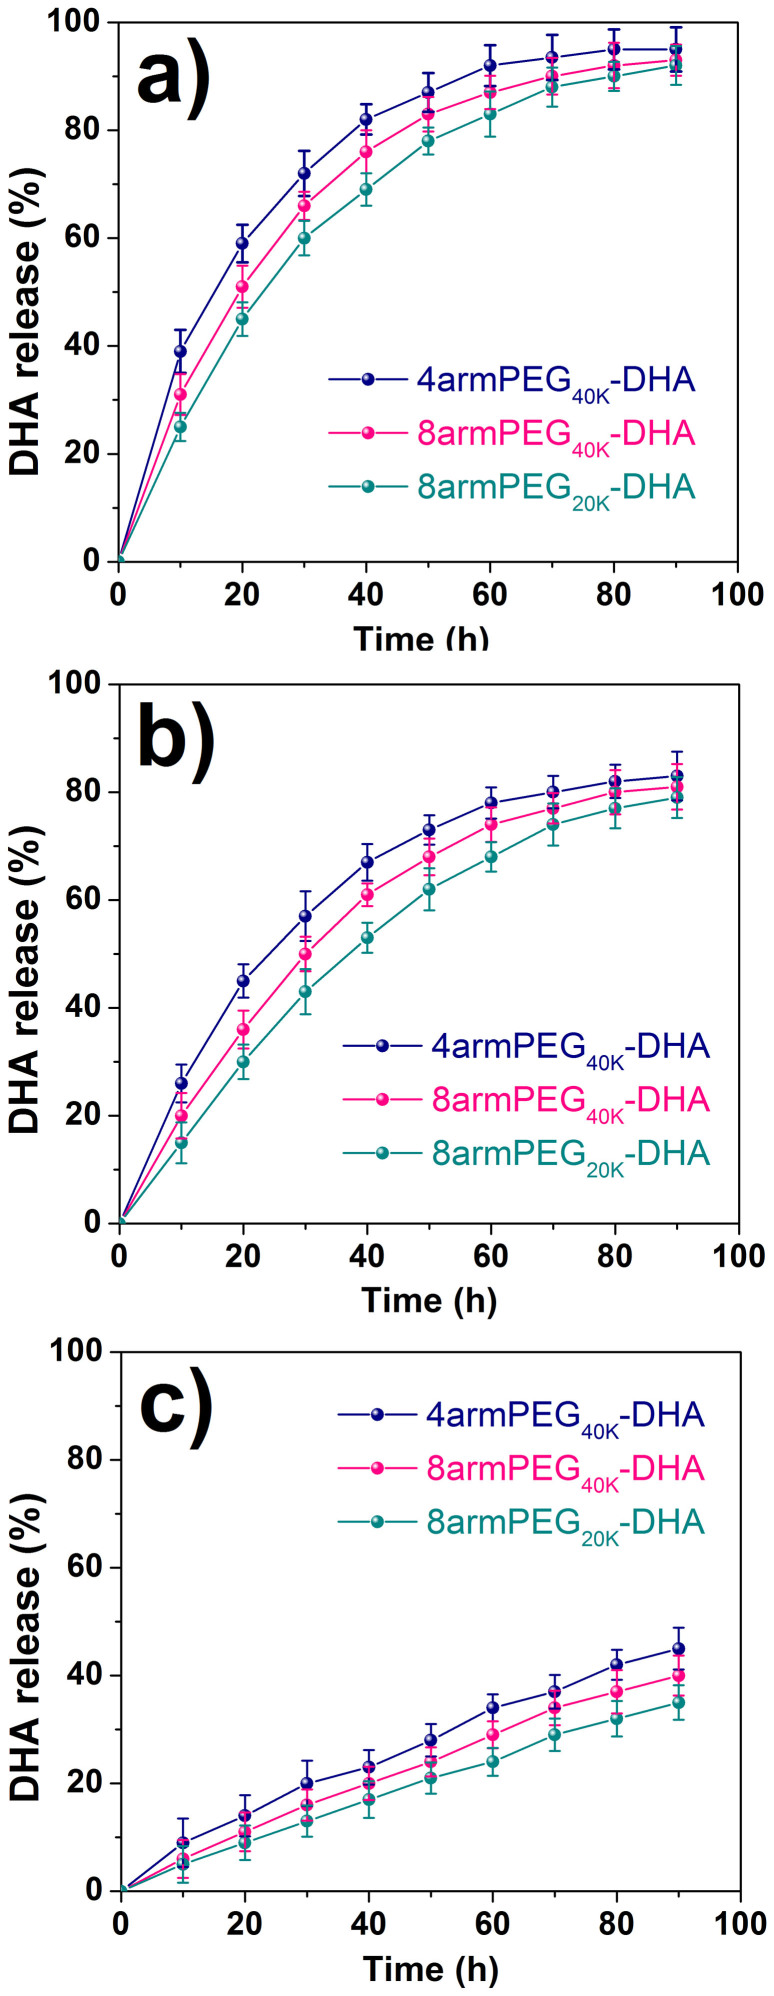
Stability of PEG-DHA conjugates in water at 37°C.Experiments were done at pH 8.1 (a), at pH 7.4 (b), and at pH 6.1 (c) for 4armPEG40K-DHA, 8armPEG40K-DHA, and 8armPEG20K-DHA. The presence of native DHA was monitored as a function of time. Data was acquired by UV-Vis analysis (n = 3, error bars represent standard deviation).